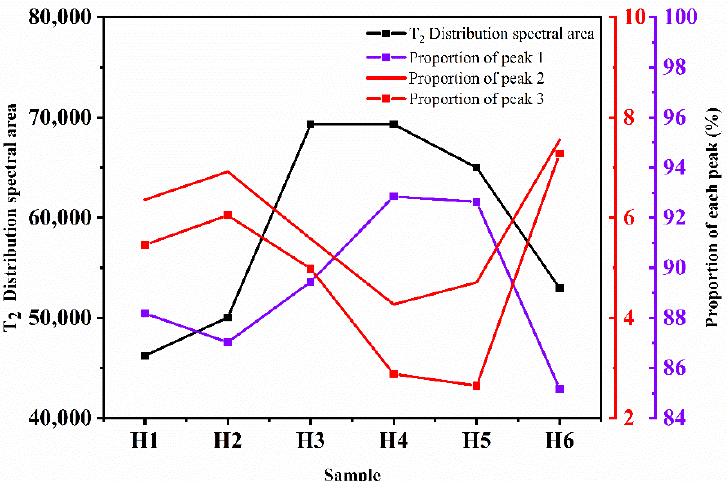
Figure 10. T 2 spectrum area and proportion of the peak value of the T 2